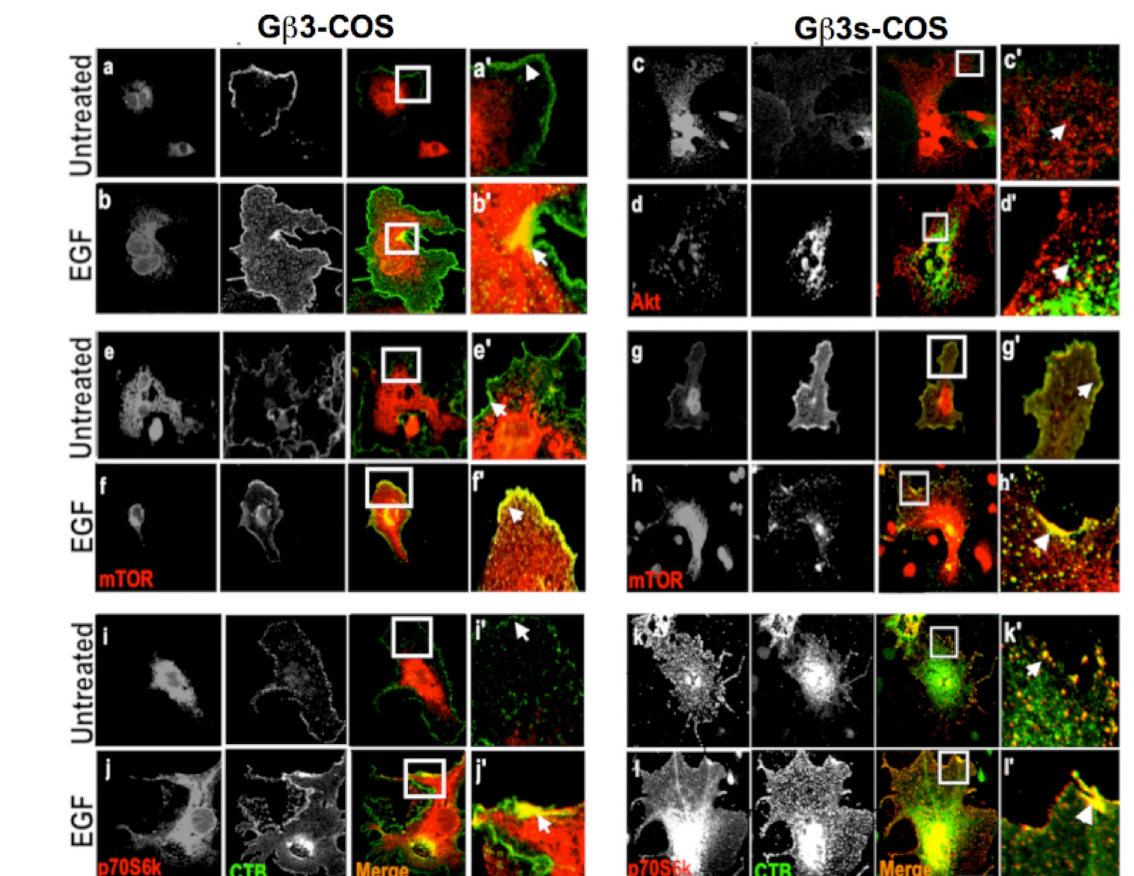
Figure 5. Gβ3s containing cells exhibit enhanced co-localisation of mTOR and p70 S6K with caveolae while mislocalisation of AKT. Cholera toxin B (CTB) subunit uptake studies were performed in G b 3-COS and G b 3s-COS cells upon EGF stimulation. Cells were treated with CTB for 2 hr and stimulated with EGF, fixed and co-immunostained with AKT, mTOR and p70 S6K antibodies and secondary antibodies conjugated to Alexa Flour 568. G b 3s-COS cells lack co-localisation of AKT with CTB-FITC (c & d with highlighted boxes shown as c’ & d’) denoted by arrowheads when compared to G b 3-COS (a & b with highlighted boxes shown as a’ & d’). Immunostaining of mTOR and p70 S6K revealed co-localisation with CTB-FITC both in untreated (g’ & k’) and EGF stimulated (h’ & l’) in G b 3s-COS while only in EGF stimulated states in G b 3-COS cells (compare e’ and i’ with f & j). Images were taken from different fields of view under a 40x objective with further 1.5x magnification. Bar = 13 m m, bar in highlighted